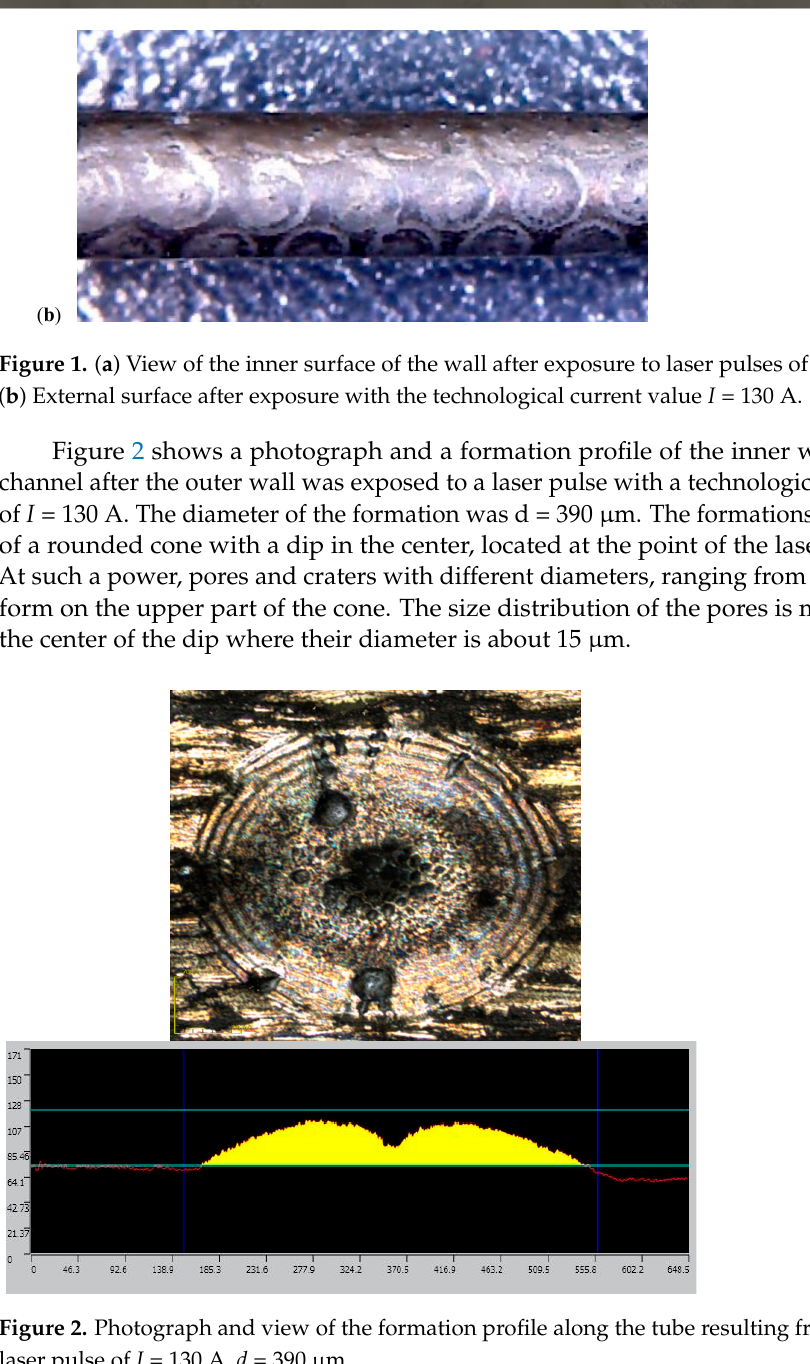
laser pulse of I = 130 A, d = 390 µm.